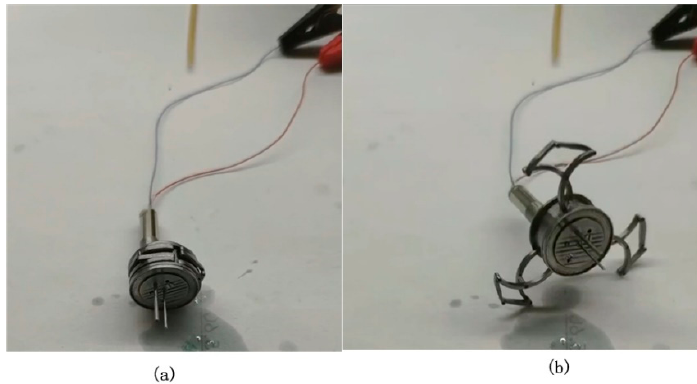
Figure 5. Prototype of the expanding mechanism: ( a ) Original state and ( b ) open state.